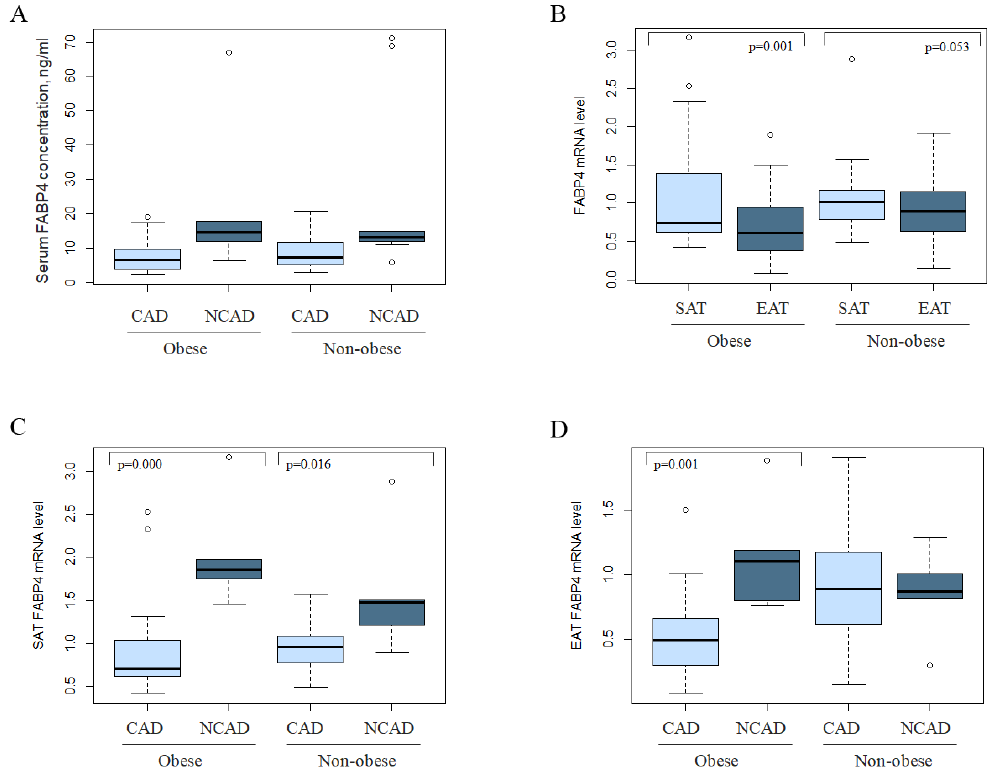
Figure 1 ‒ FABP4 serum concentration (A) and gene expression in adipose tissue in obese and non-obese subgroups: comparative analysis of the FABP4 gene expression in subcutaneous and epicardial fat depots (B); FABP4 mRNA level in subcutaneous (C) and epicardial adipose tissue (D) in CAD and NCAD individuals.